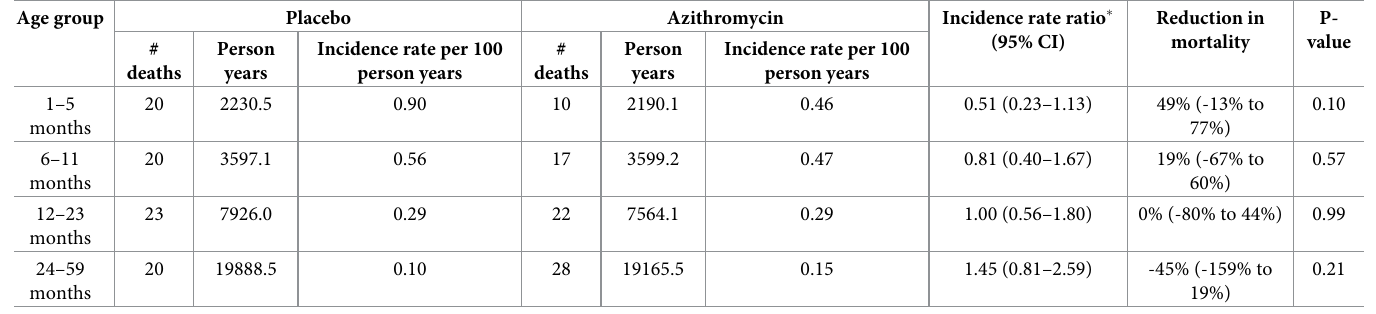
Table 2. Mortality due to pneumonia/diarrhea by age group and